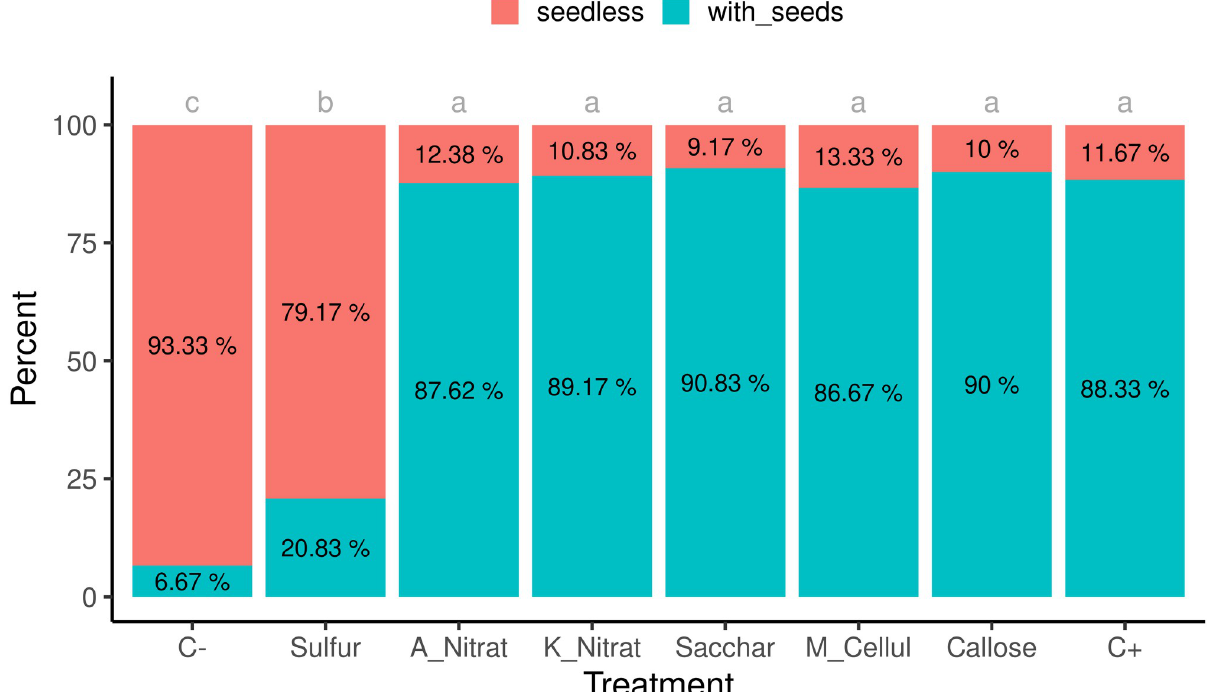
(Fig 2). When analyzing seed number per fruit, but excluding the seedless fruit, a different behavior was noted for seed number per fruit in the sulfur treatment versus the other treat- ments (S4 File). When considering only the seedy fruit, the sulfur treatment continued to par- tially reduce seed number (S4 File).